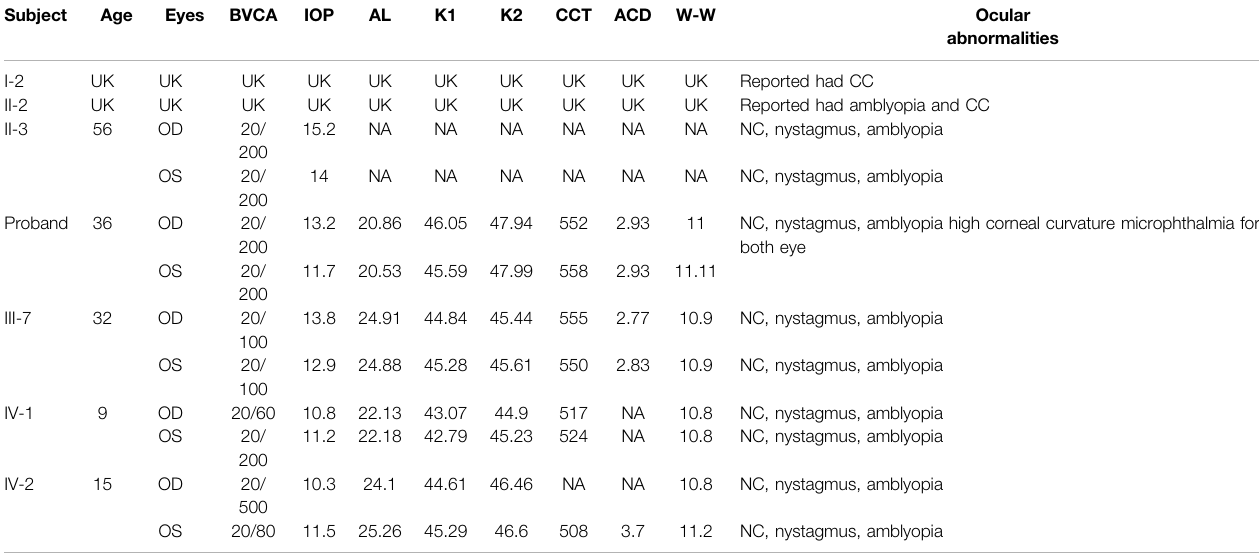
TABLE 1 | Ocular abnormities in a novel missense mutation in the CRYGD gene for congenital cataract.